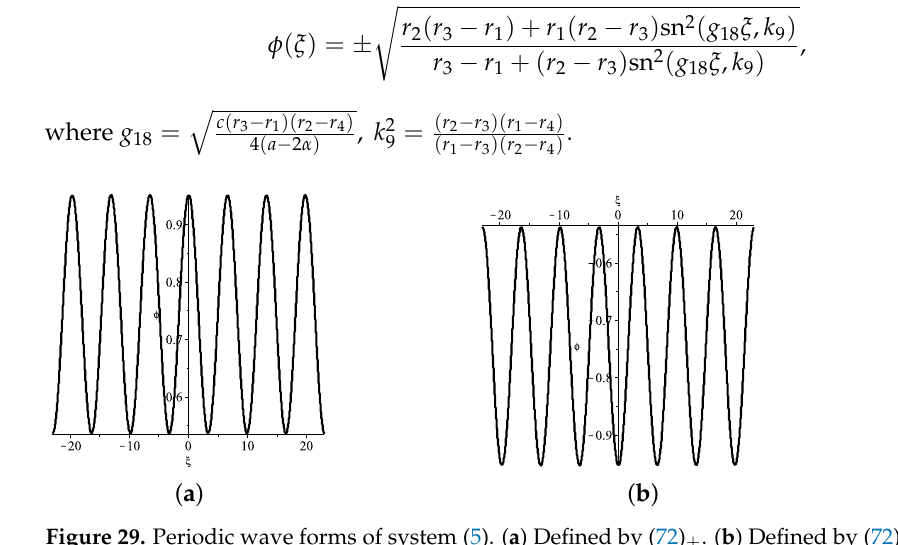
Figure 29. Periodic wave forms of system (5). ( a ) Defined by (72) + . ( b ) Defined by (72) −